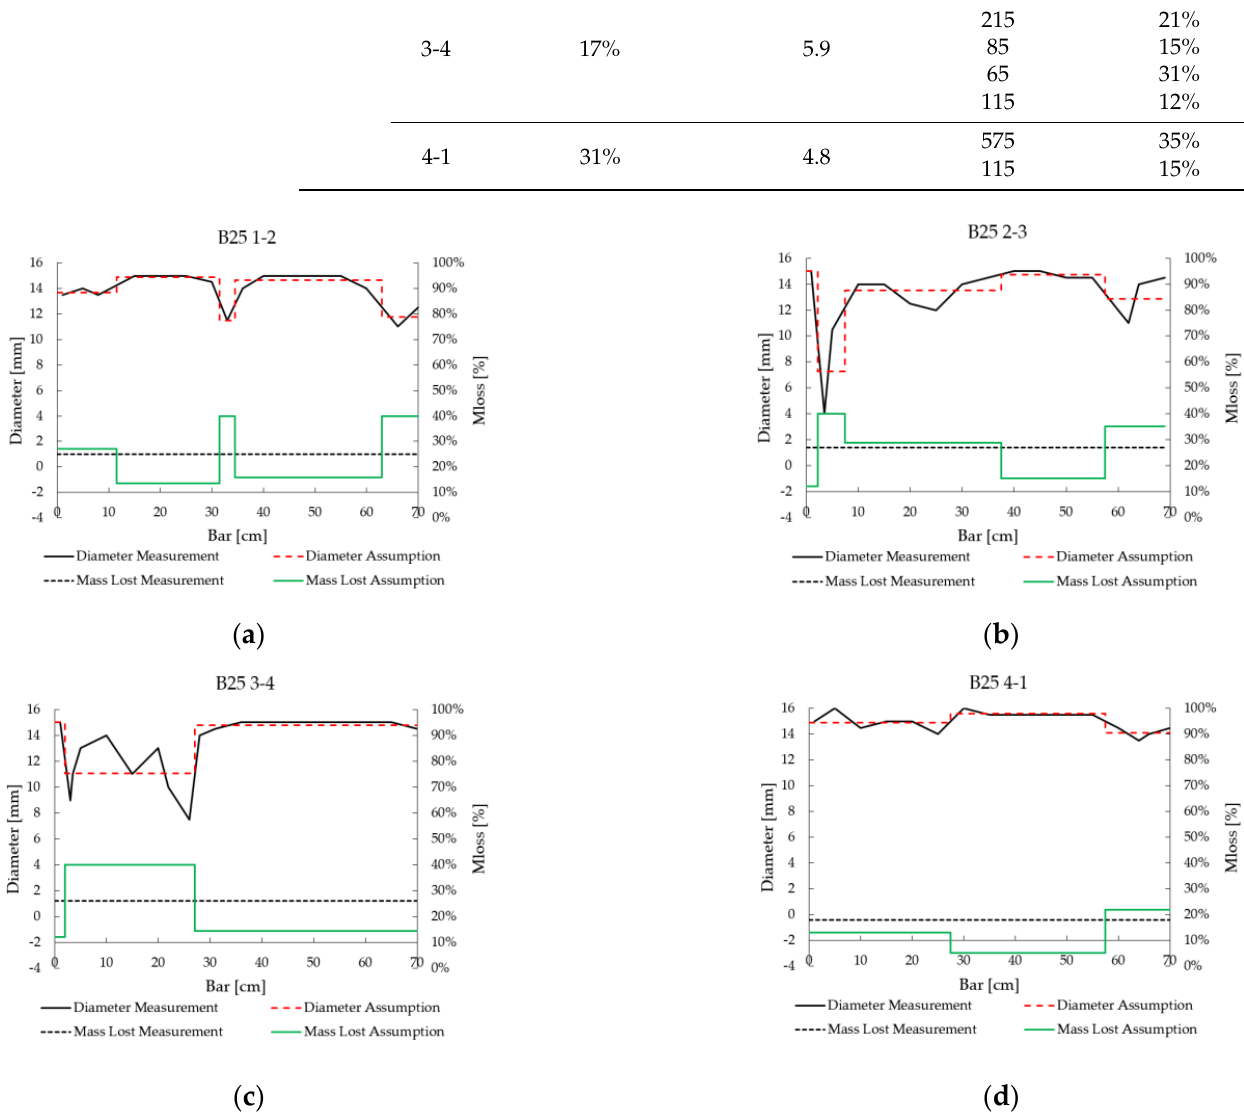
Figure 9. Assumptions for corroded bars (modelling strategies 3 and 4) compared with original measurement, Specimen B25. ( a ) Bar 1-2, ( b ) Bar 2-3, ( c ) Bar 3-4, ( d ) Bar